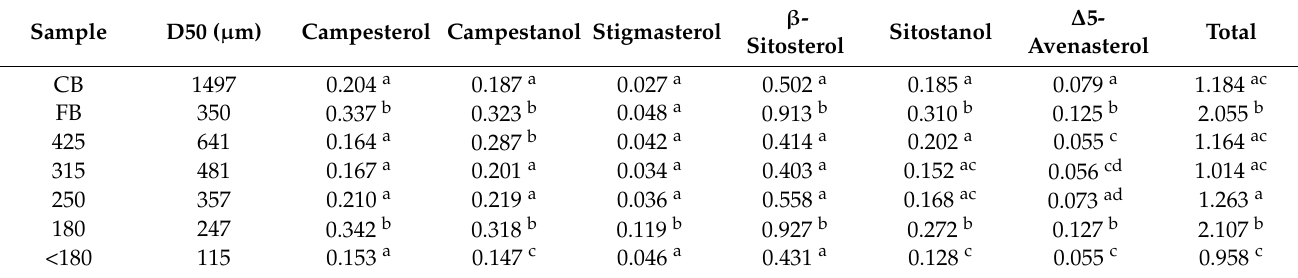
Table 2. Phytosterol content (mg/g db) of bran